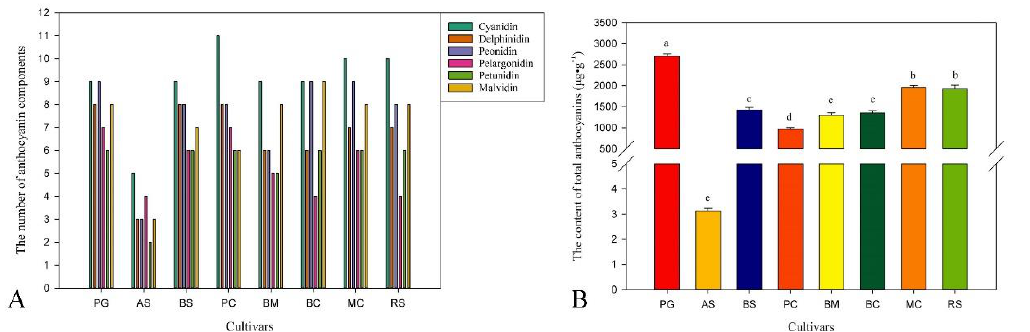
Figure 6. The number of anthocyanin components ( A ), and the contents of total anthocyanins in petals of Hibiscus syriacus ( B ). In B, different letters indicate significant differences at p ≤ 0.05. Table 2. Stepwise regression equation of color space value with anthocyanin of Hibiscus syriacus . Type